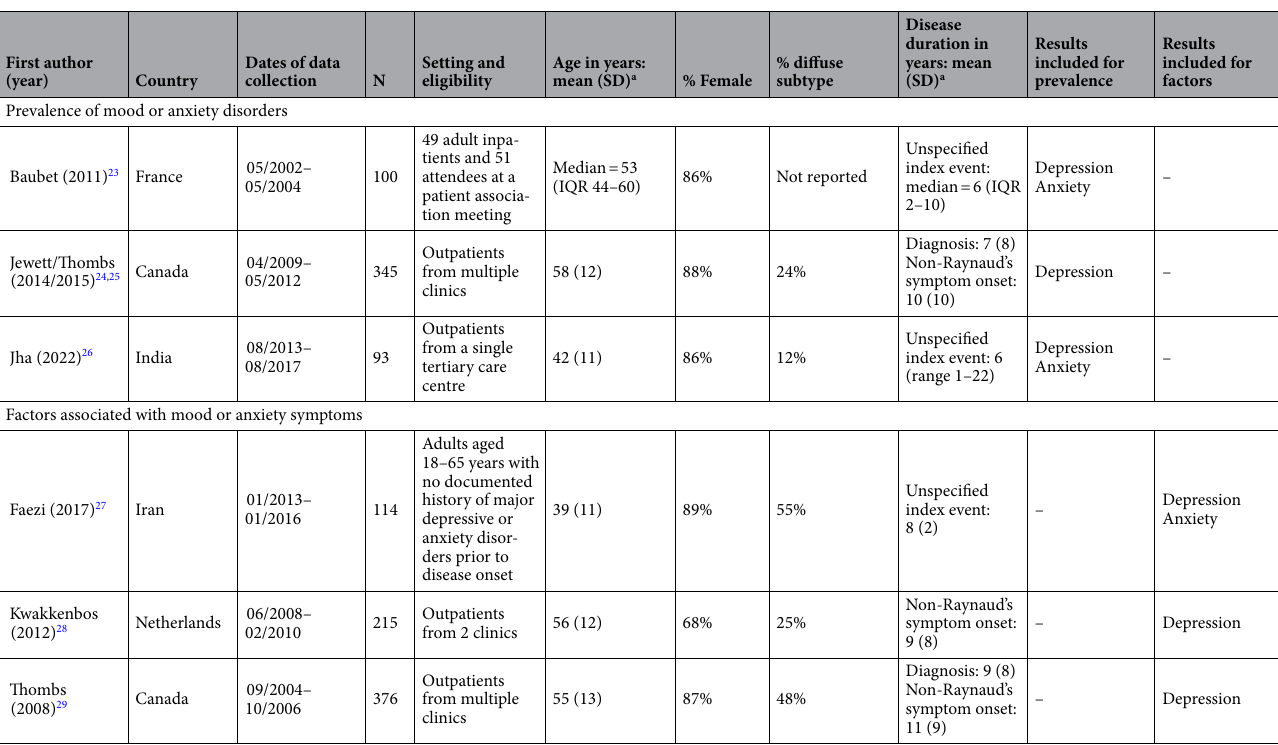
Table 1. Included study characteristics. IQR inter-quartile range, SD standard deviation. a Mean and standard deviation reported unless not